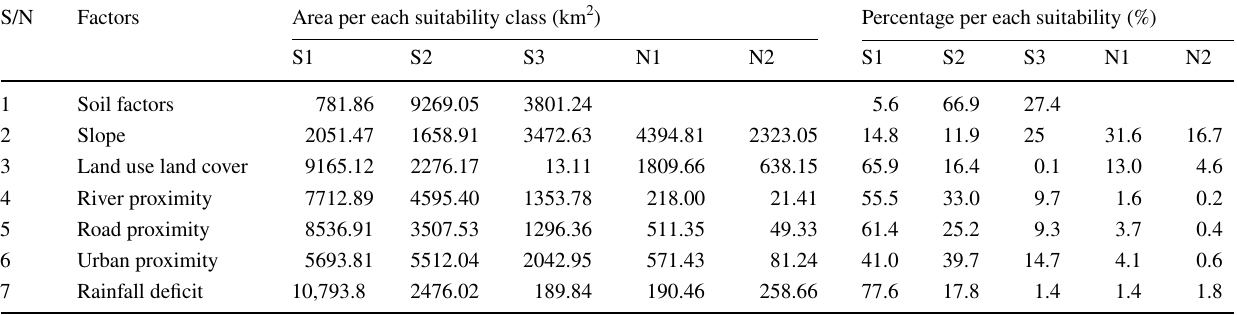
Table 7 The area and percentage of each factor’s suitability class